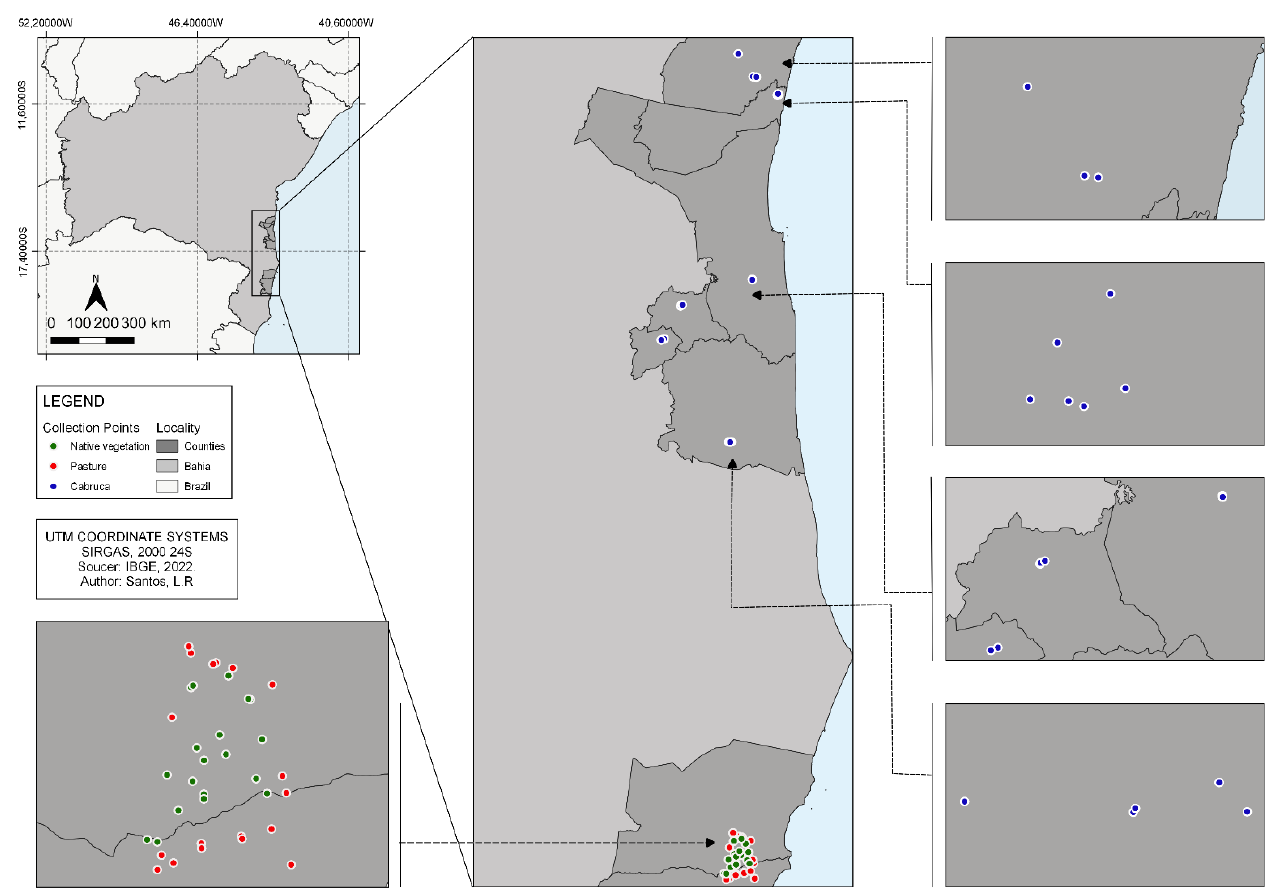
Figure 1. Map of the municipalities with the sampling points in areas of native vegetation (green), cabruca (blue), and pasture (red).